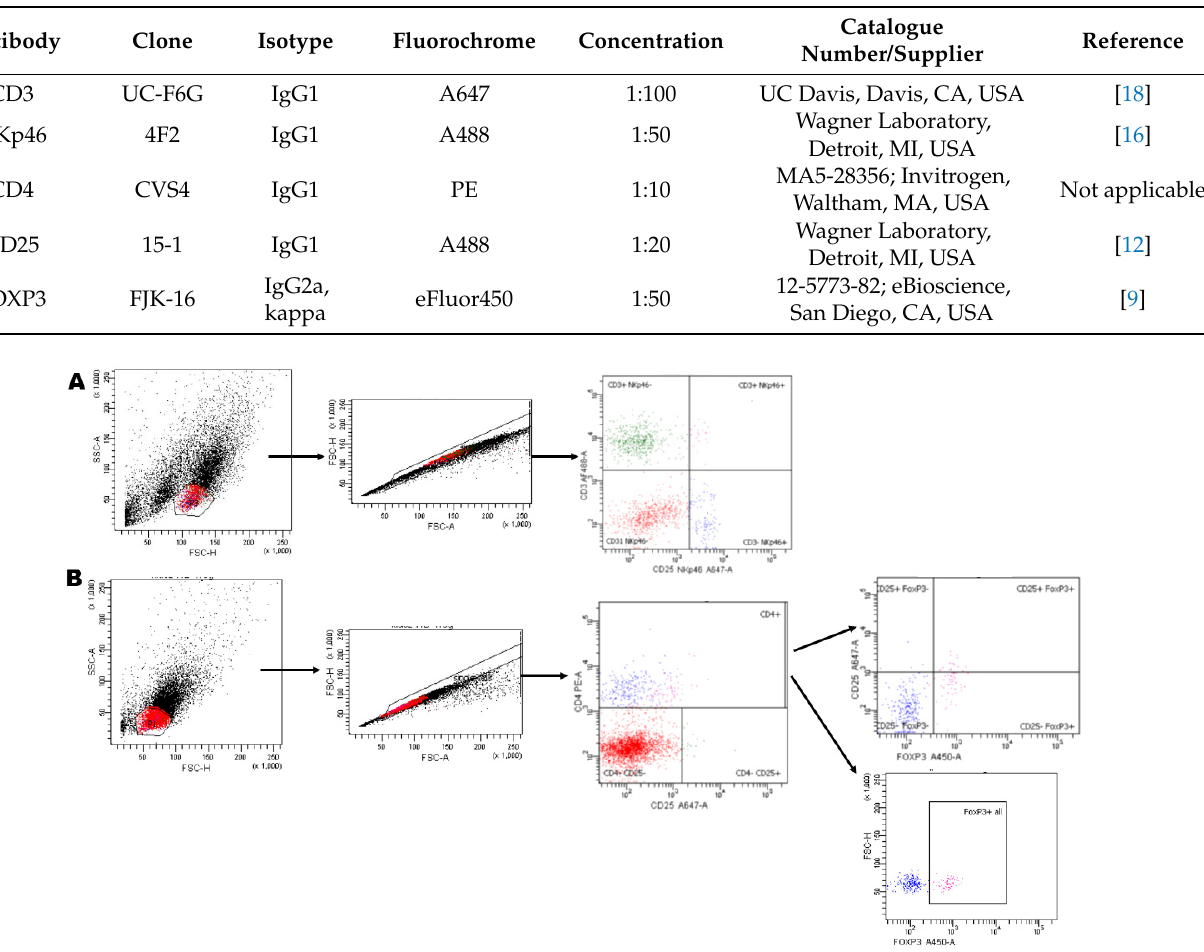
Figure 1. Gating strategy for NK cells ( A ) and regulatory T cells (Tregs) ( B ) present in the endometrium of cycling mares. ( A ) Gate was set for the lymphocytes (forward and side scatter); cells then gated to exclude cell debris and doublets; based on the fluorescence signal populations of lymphocytes expressing (or not), CD3 and NKp46 (CD3 − NKp46 + lymphocytes) were determined. ( B ) Gate was set for the lymphocytes (forward and side scatter); cells gated to exclude cell debris and doublets; next, the gate was positioned on CD4 + cells; based on the fluorescence signal within the CD4 + lymphocytes’ gated population, cells expressing FOXP3 alone (representing CD4 + FOXP3 + lymphocytes) or FOXP3 and CD25 (representing CD4 + CD25 + FOXP3 + lymphocytes) were